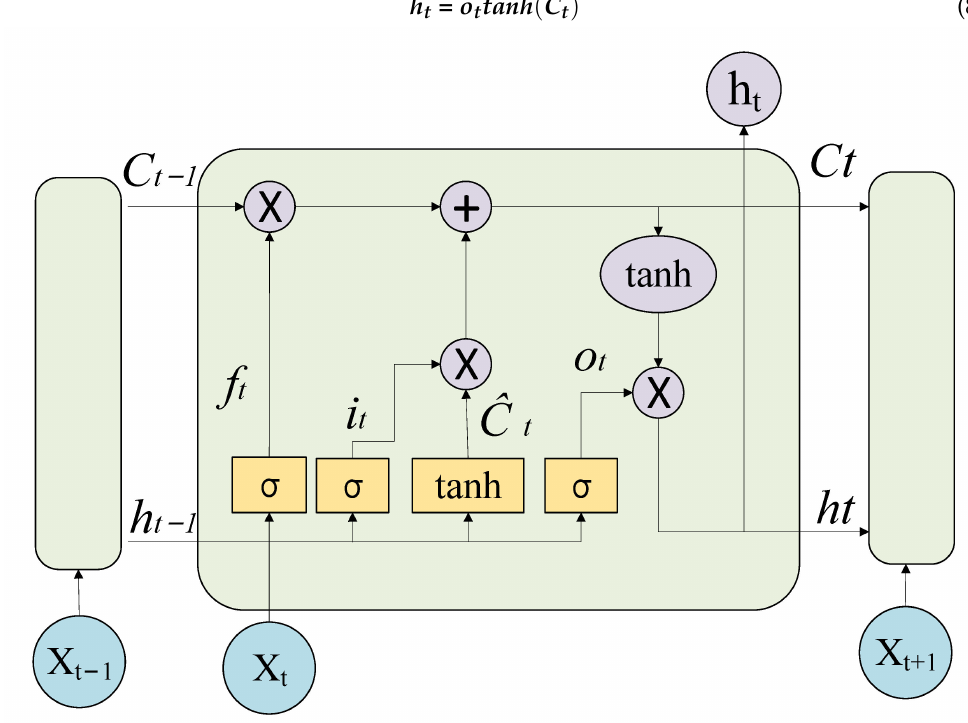
Figure 1. Structure of the LSTM